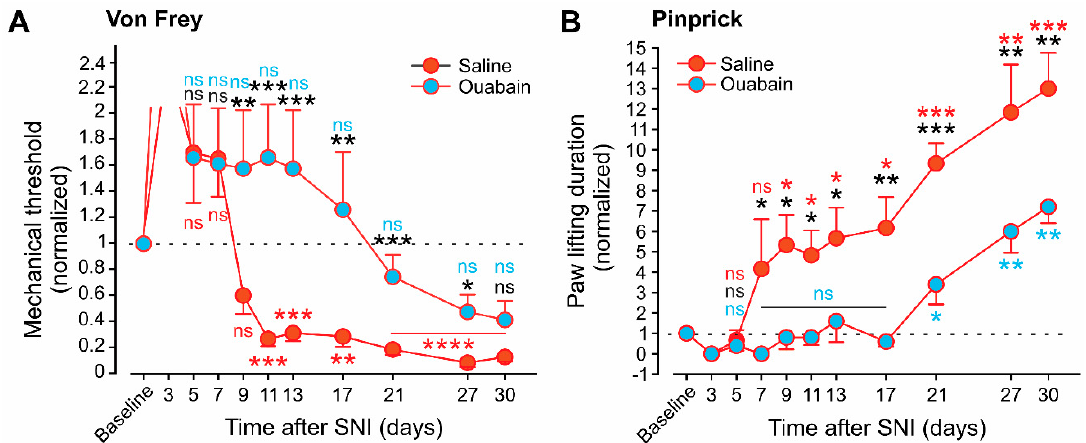
Figure 7. Ouabain diminished neuropathic pain. ( A , B ). Changes of the response to VF ( A ) and pinprick ( B ) at the indicated times following SNI in animals treated with ouabain (blue circles) and saline (red circles). The baseline value represents the mean value of the 3 tests performed at three consecutive days before SNI or sham surgery. All of the values were normalized to the baseline value. The dotted line indicated the baseline values. Black letters and asterisk—two-way RM ANOVA with posthoc Bonferroni comparison between saline and ouabain groups; blue letters and asterisk - one-way RM ANOVA with posthoc Bonferroni comparison between baseline values and values at different time points in the ouabain group; red letters and asterisk—one-way RM ANOVA with posthoc Bonferroni comparison between baseline value and values at different time points in the saline group. *** p < 0.001; ** p < 0.01; * p < 0.05; ns—not significant, n = 6 rats in each group.